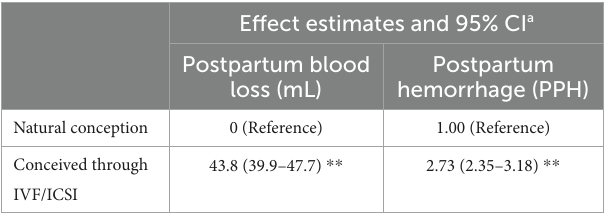
TABLE 3 Adjusted associations between the use of IVF/ICSI and the amount of postpartum blood loss or risk of PPH.